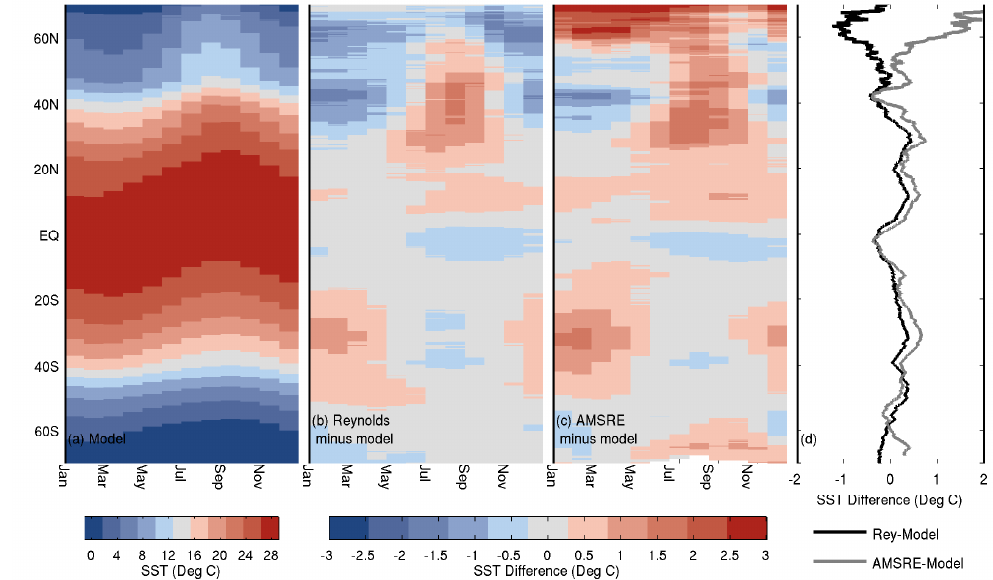
Fig. 3. (a) Seasonal climatology of zonally averaged modelled SST, the zonal average of the difference between modelled and observed SST seasonal climatology using (b) Reynolds SST and (c) AMSR-E SST, and (d) the time-averaged and zonally averaged difference between observed and modelled SST.